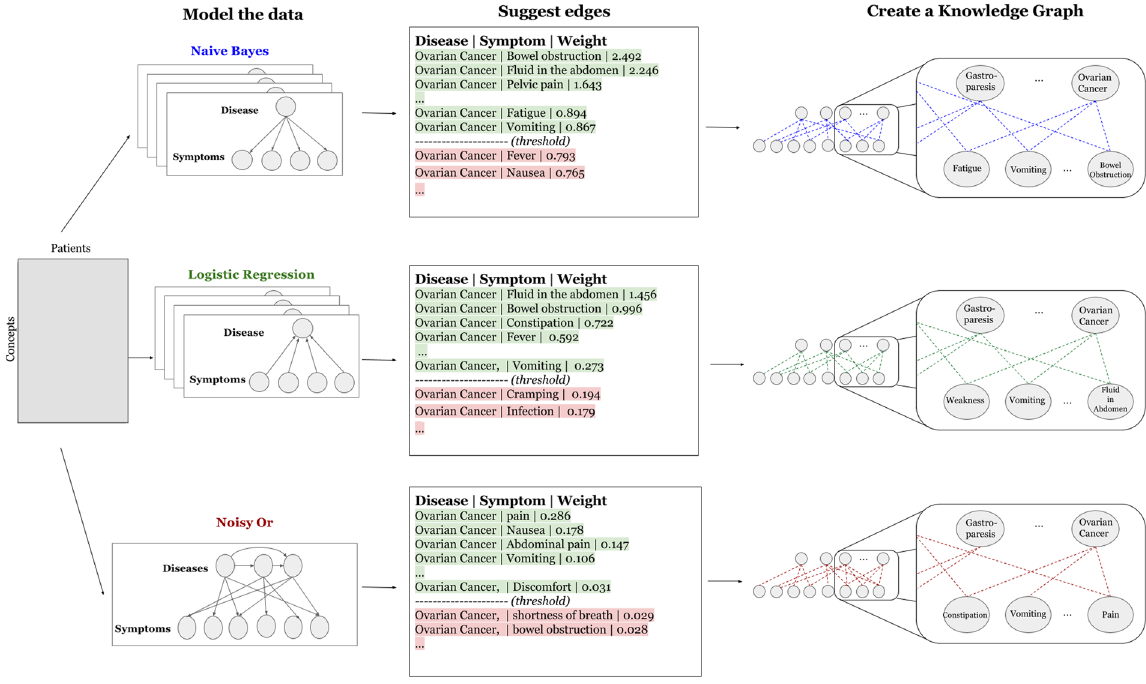
Figure 2. Workflow of modeling the relationship between diseases and symptoms and knowledge graph construction, for each of our 3 models (naive Bayes, logistic regression and noisy